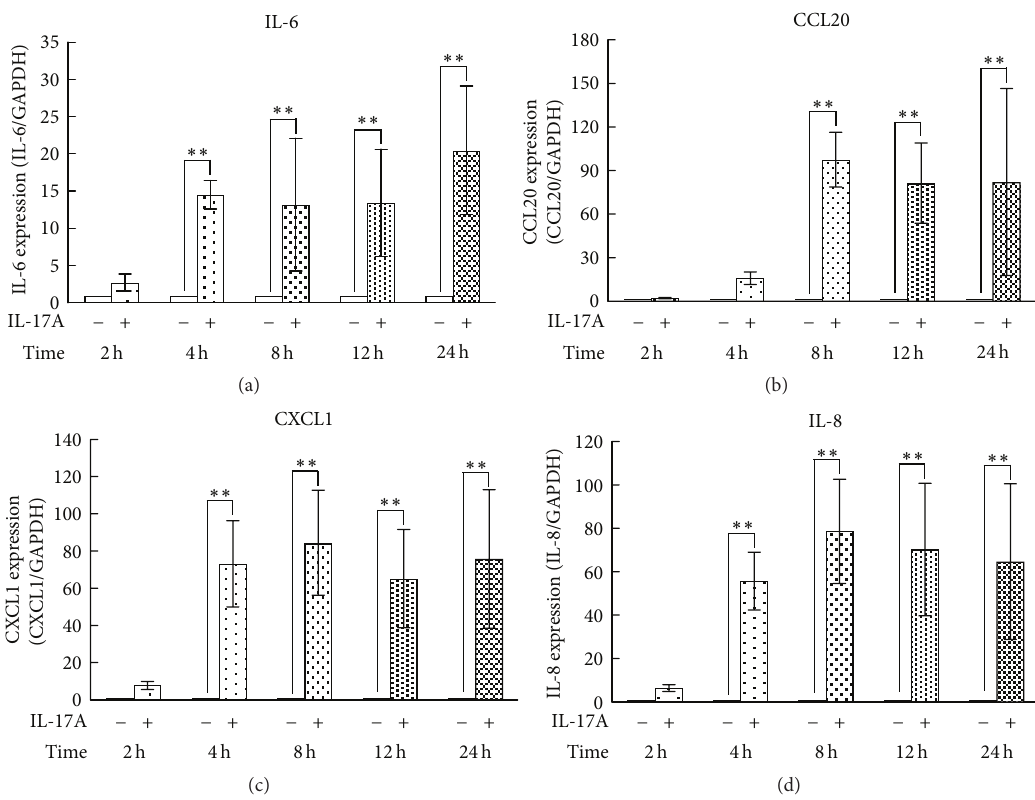
Figure 4: Time course of IL-17A induction of the mRNA expression of IL-6, CCL20, CXCL1, and IL-8 in synovial fibroblasts. The effect of IL-17A on (a) IL-6, (b) CCL20, (c) CXCL1, and (d) IL-8 gene expression in synovial fibroblasts was analyzed using real-time PCR following culture of the cells with or without IL-17A (10ng/mL) for 4, 8, 12, or 24h. Data are shown as means ± SD ( 𝑛 = 5 ); ∗∗ 𝑃 < 0.01 .